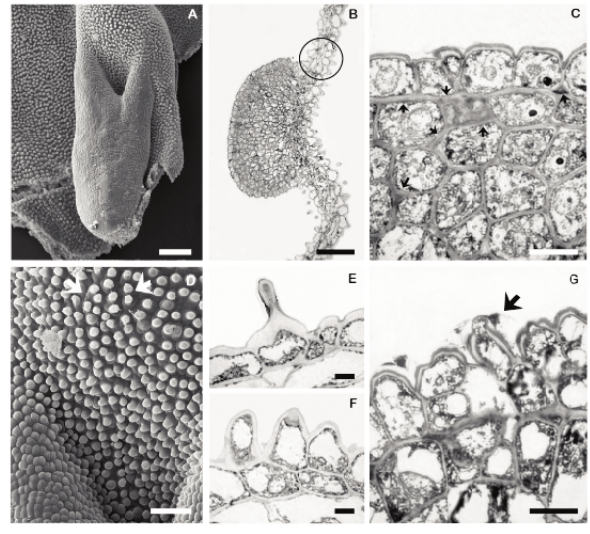
Fig. 3 -Nectary of B. microphylla G. Forst. A-D SEM micrograph. B- C, E-G light micrograph. A, nectary view at the base of petal; B, section of a petal and a nectariferous area; C, detail of tissue of nectariferous area of a flower on stage 59; intercellular space with nectar (arrows); D, detail of circle in the picture A, epidermis with glands, arrows show secretory glands. E, detail of circle in the picture B, petal outer epidermis; F, detail of circle in the picture B, petal inner epidermis; G, detail of tissue of nectariferous area of a flower on stage 60, arrow indicates an epidermal cell in